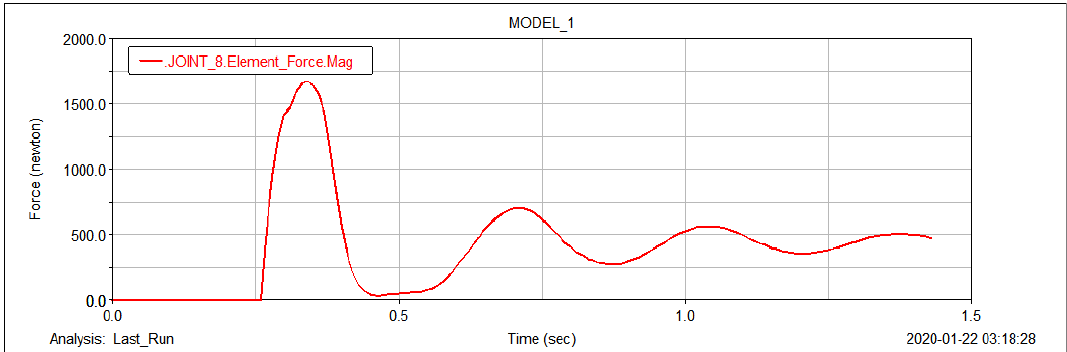
Figure 14. Actuator locking load evaluation during impact simulation. This figure shows variation of axial force with time acting on actuator during impact